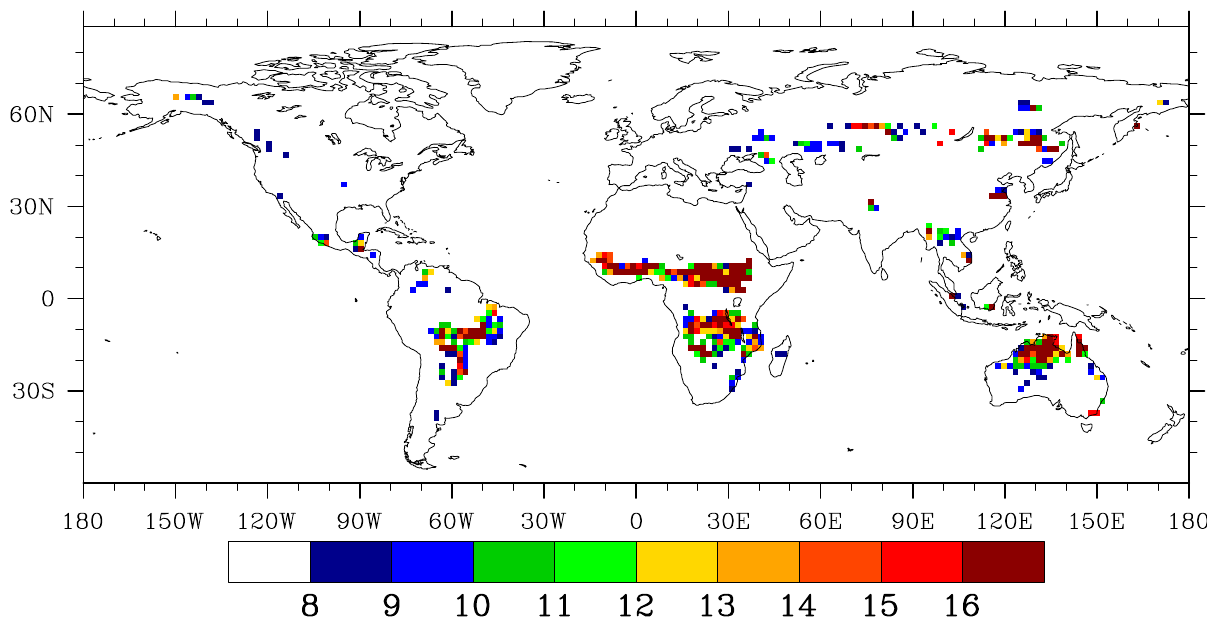
Fig. 1. MODIS 8-day active fire counts (count (1000km 2 ) − 1 8d − 1 ) in the peak 8-day of each year averaged over 2001–2009. 1000km 2 are representative area set by CTEM-FIRE. Regions where value > 8count (1000km 2 ) − 1 8d − 1 represent regions of more than 1count (1000km 2 ) − 1 d − 1